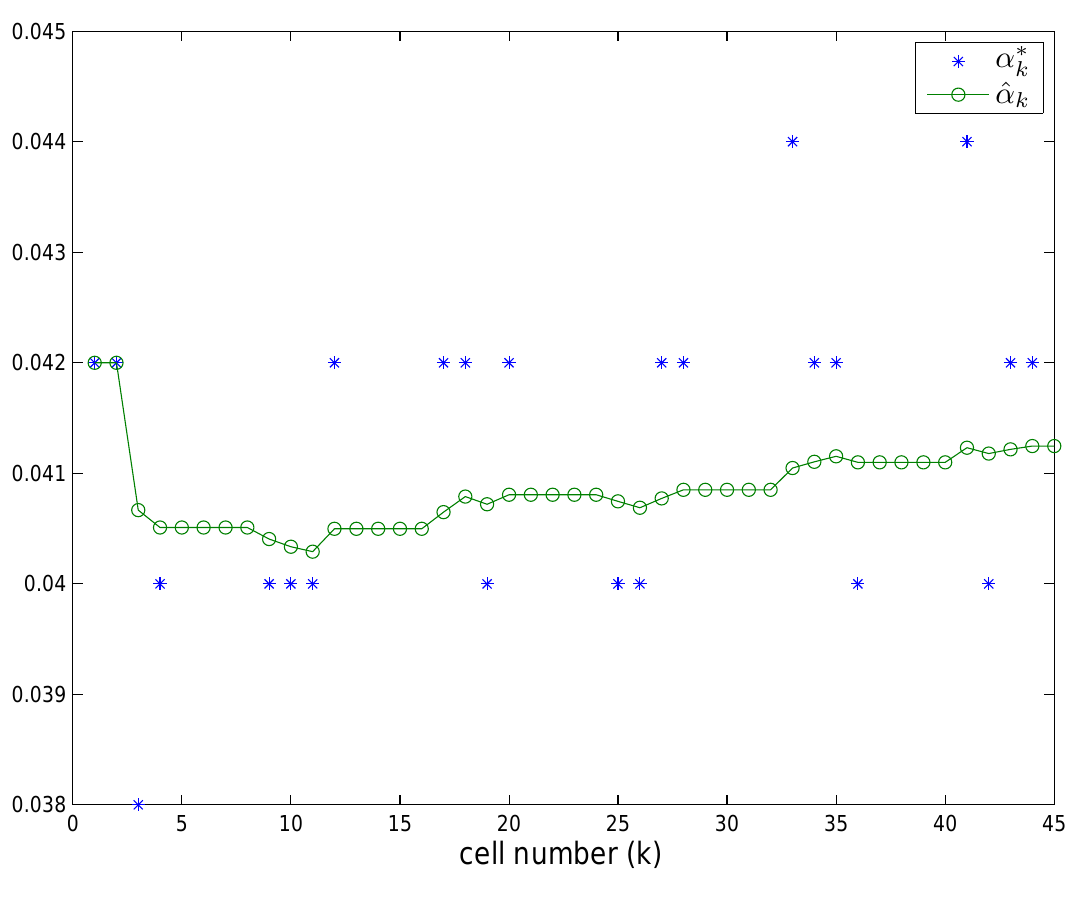
and ^ (cid:11) (cid:3) k k